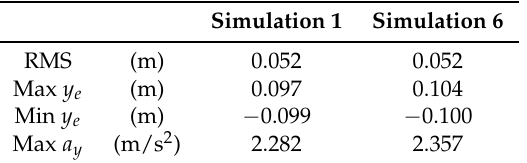
Table 5. Evaluation parameters for evaluation of steering output.